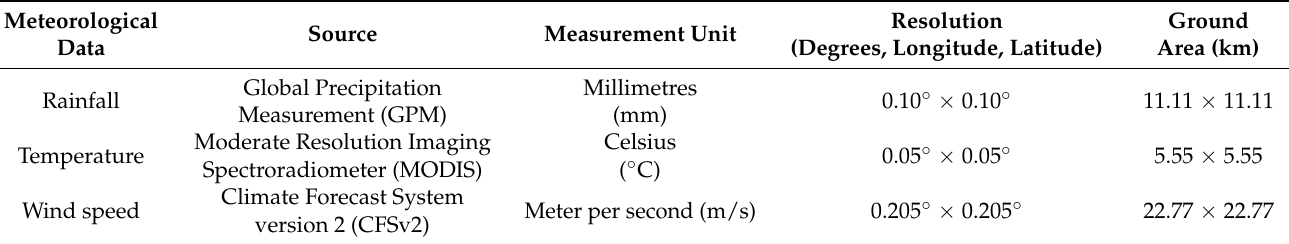
Table 1. EO meteorological